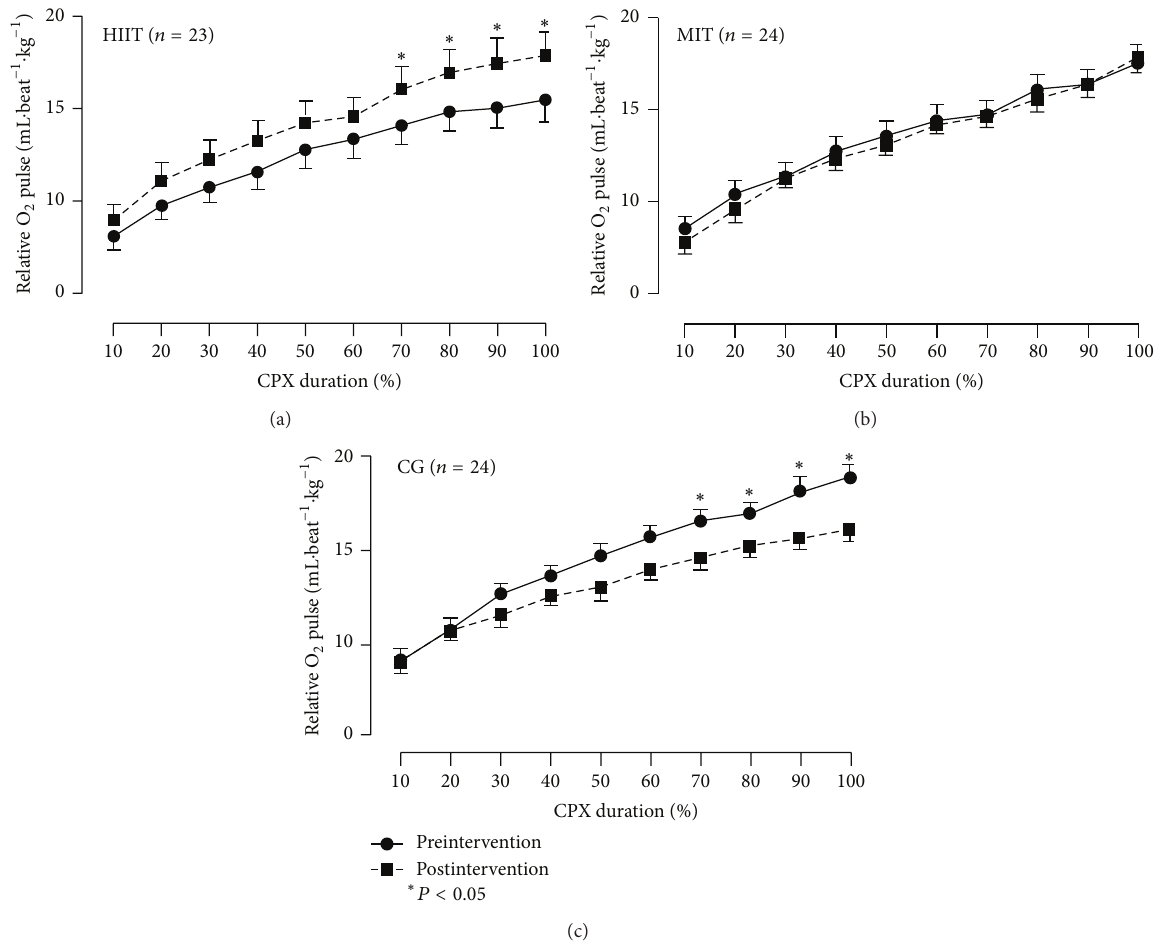
Figure 2: The relative O 2 pulse curves as a function of percentage time during CPX, before and after intervention. (a) HIIT denotes high intensity interval training group. (b) MIT denotes moderate intensity training group. (c) CG denotes control group. ∗ 𝑃 < 0.05